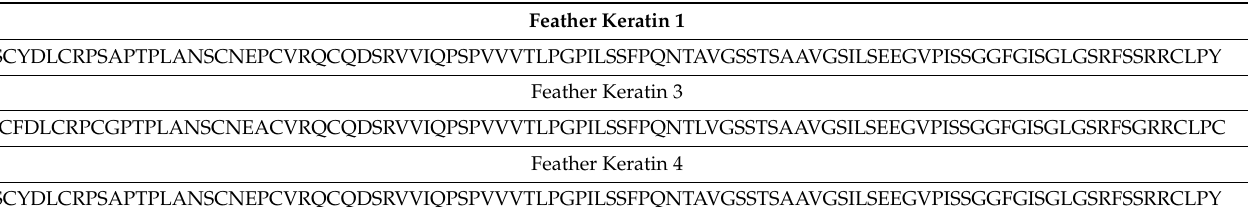
Table 2. Peptide sequence of chicken feather keratin 1, 3 and